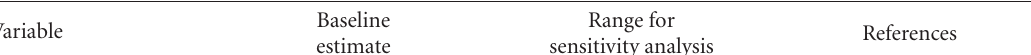
Table 1: Probability estimates used in the decision